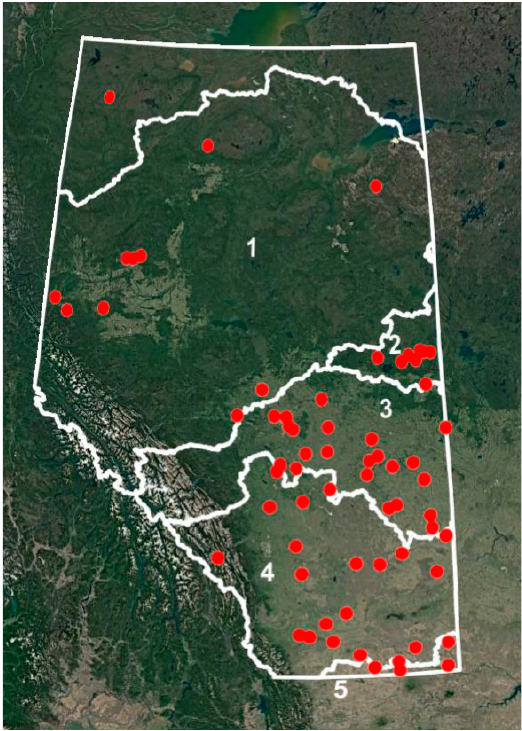
Figure 2. Distribution of 65 piezometric wells under study in Alberta (red dots), covering five Canadian river basins (1: Peace-Athabasca, 2: Churchill, 3: North Saskatchewan, 4: South Saskatchewan, 5: Missouri).